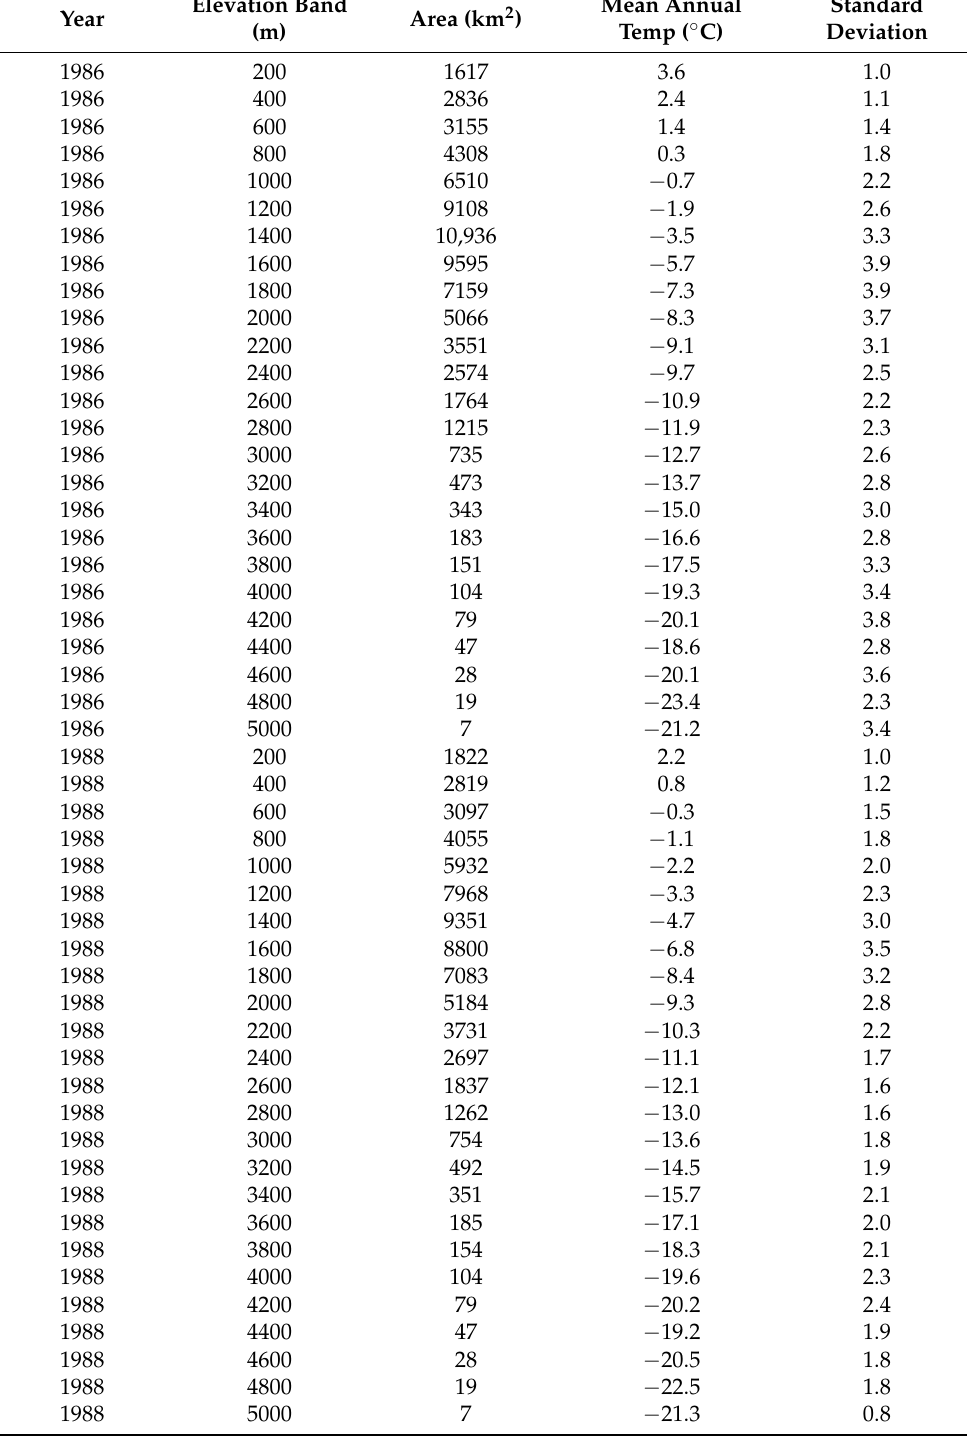
Table A3. Summary of overall glacier-covered area by biannual composite, 200 m elevation band, and mean annual temperature; elevation band label is the upper